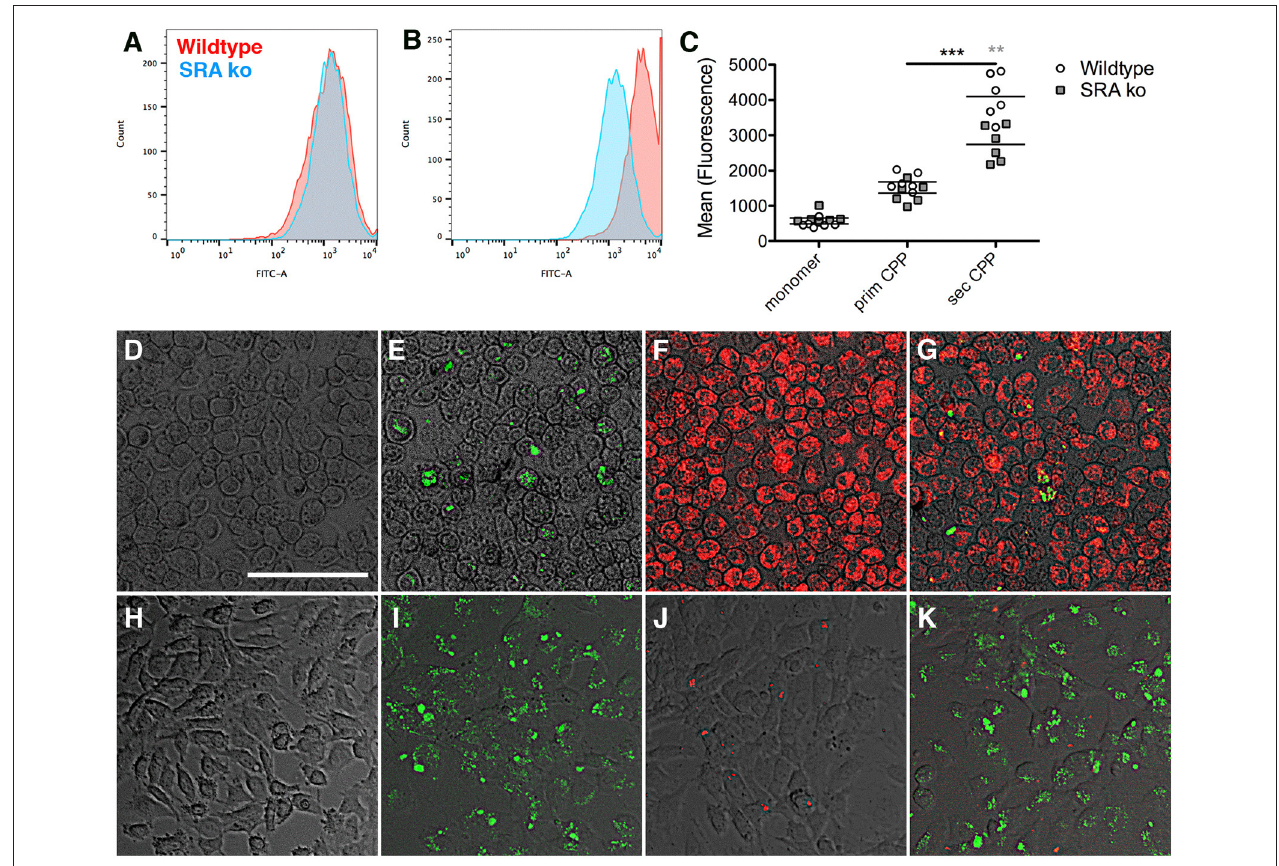
FIGURE 5 | Differential endocytosis of primary and secondary CPP in mouse macrophages and endothelial cells. (A–C) Primary bone marrow macrophages derived from wildtype and scavenger receptor A-deficient mice (SRA ko) were treated with fluorescence labeled fetuin-A monomer (not shown) or (A), primary or (B), secondary CPP for 1h, and endocytosis was analyzed by flow cytometry. (C) Quantitation of endocytosis shows negligible fetuin-A monomer endocytosis, low primary CPP endocytosis but strong secondary CPP endocytosis, which was reduced in SRA-deficient macrophages vs. wildtype. (D–G) Fluorescence micrographs of wildtype macrophages and (H–K), HUVEC cells treated for 1h with (D,H) labeled fetuin-A monomer (E,I) labeled primary CPP (green fluorescence), (F,J) secondary CPP (red fluorescence), or (G,K) a mixture of primary and secondary CPP. Macrophages endocytosed predominantly secondary CPP (E–G) , but HUVEC endocytosed predominantly primary CPP (I–K), regardless of whether CPP were incubated individually (E,F,I,J) or in combination (G,K) . Neither cell type endocytosed detectable amounts of fetuin-A monomer (D,H) . Scale bar in (D) 75 µ m. ** p < 0.01, *** p <